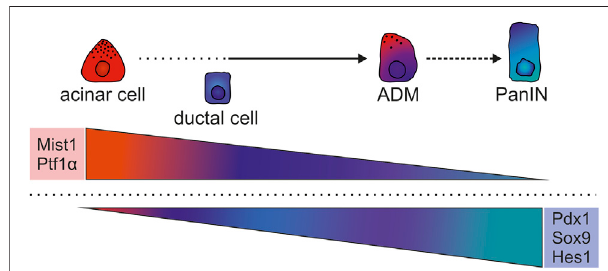
FIGURE 2 | Modulated expression of key TFs of the process of transdifferentiation during ADM. Differentiated acinar cells are speci fi ed and maintained by Gata4, Ptf1 α , Mist1, and others, whereas duct cells depend on Sox9, Hes1, and others. During ADM several duct-speci fi c TF networks areinducedincludingSox9andHes1,whileacinar-speci fi cnetworksinvolving Ptf1 α andMist1arecollapsing. ADMcellsalsoadoptnon-ductlikefeaturesby activation of Pdx1, gaining more progenitor-like characteristics. Although Gata6 is required for acinar speci fi cation, but absent in mature acinar cells, its continuous expression prevents